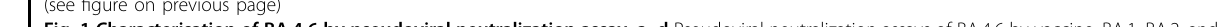
Fig. 1 Characterisation of BA.4.6 by pseudoviral neutralization assay. a – d Pseudoviral neutralization assays of BA.4.6 by vaccine, BA.1, BA.2, and BA.4.5 immune serum. IC 50 values for the indicated viruses using serum obtained from vaccinees 28 days following their third dose of P fi zer BNT162b2 vaccine ( n = 22, a ). IC 50 values for the indicated viruses against serum from volunteers suffering vaccine breakthrough BA.1 ( n = 14, b ), BA.2 ( n = 23, c ) and BA.4/5 ( n = 11, d ) infections. Geometric mean titers are shown above each column. The Wilcoxon matched-pairs signed rank test was used for the analysis and two-tailed P values were calculated. e Neutralization curves for a panel of 28 monoclonal antibodies made from samples taken from vaccinees infected with BA.1 against BA.4.6 were compared with Victoria, BA.1, BA.1.1, BA.2, BA.4/5, and BA.2.75 variants. Error bars represent means ± SEM of repeat experiments. f Neutralization curves for a panel of 12 commercial monoclonal antibodies against same variants. IC 50 ± SEM values are shown in Supplementary Table